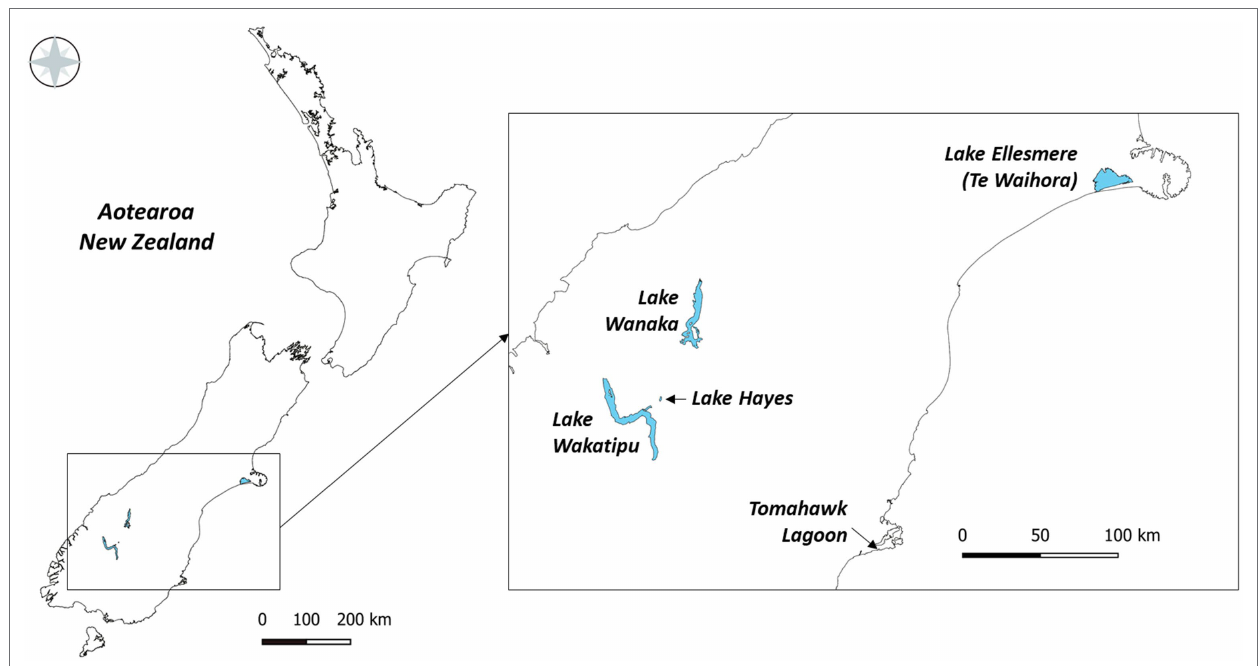
FIGURE 1 | The five lakes sampled from February 2018 to February 2019 in the South Island of New Zealand.